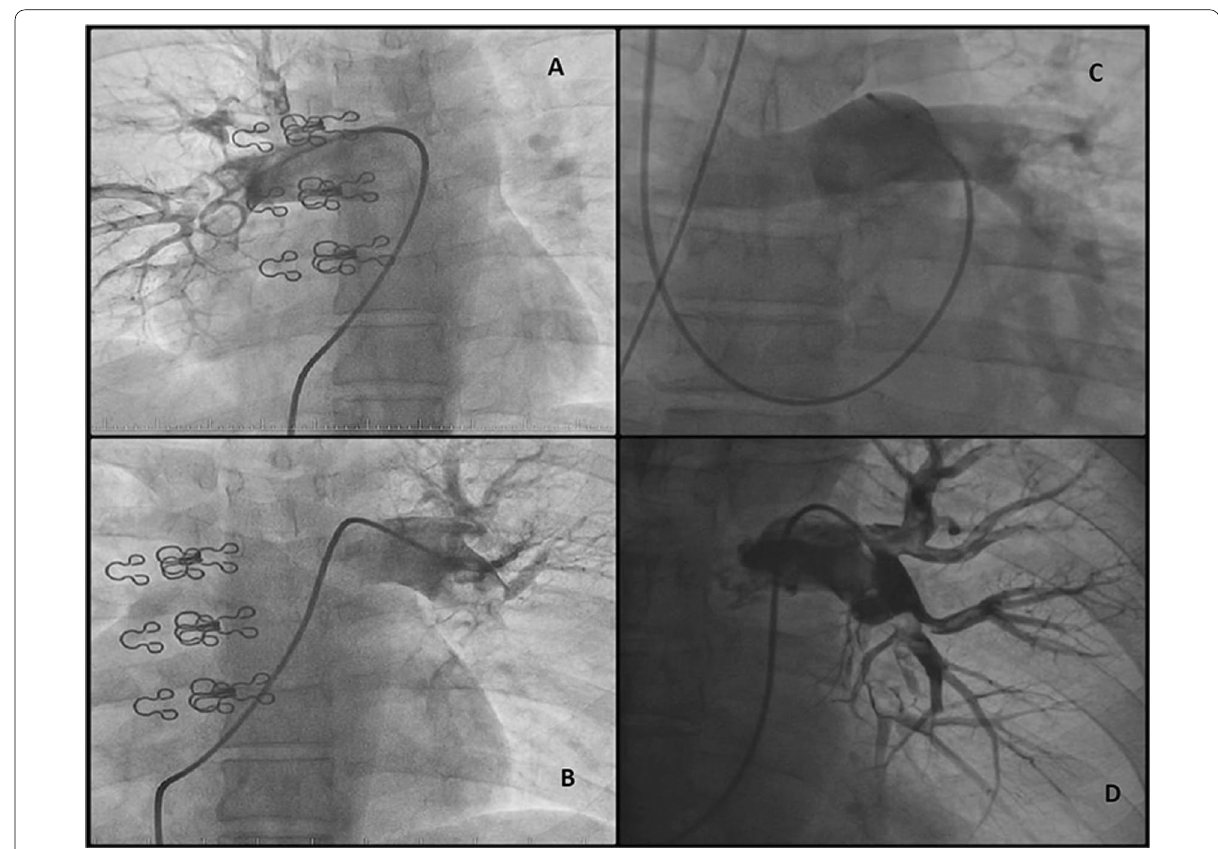
Fig. 2 Pigtail catheter in different patients’ pulmonary artery. a Pigtail cath. In right main pulmonary artery (PA) with thrombus seen at tip of catheter using 20‑ml contract injection. b The pigtail cath. in left main PA showing a thrombus at tip of cath. before fragmentation. Clips of patient spinal surgery is seen in both frames. c Pigtail cath. in main PA before bifurcation in another patient using right jugular vein for cath. insertion. d Pigtail cath.in left PA after successful fragmentation with residual thrombus in distal LPA but opened distal